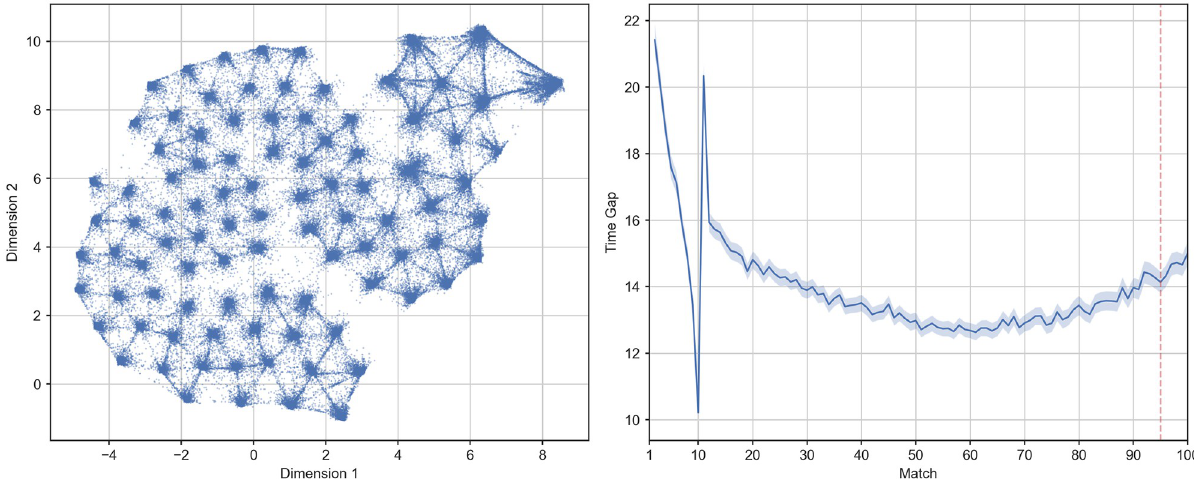
Fig 4. The left panel shows the two-dimensional projection of the observed 95 inter-match gaps in hours as generated by UMAP for the entire sample . The y and x axes represent the two dimensions individuated by UMAP. As opposed to Principal Component Analysis their associated values should be interpreted as coordinates on a plane rather than indicators of the magnitude of the two components. Each dot represents the history of inter- matches gaps for a single player while distance between dots indicates the degree of similarity between different patterns of spacing. The right panel shows the average evolution of inter-match gap in hours for the entire sample . The y axis indicates the time in hours elapsed since the previous match while the x axis indicates the order of the match. The solid line indicates the mean value while the shaded region shows the 95% confidence interval. The dotted red line separates the observation period (i.e., the first 95 matches) from the evaluation period (i.e., the last 5 matches).